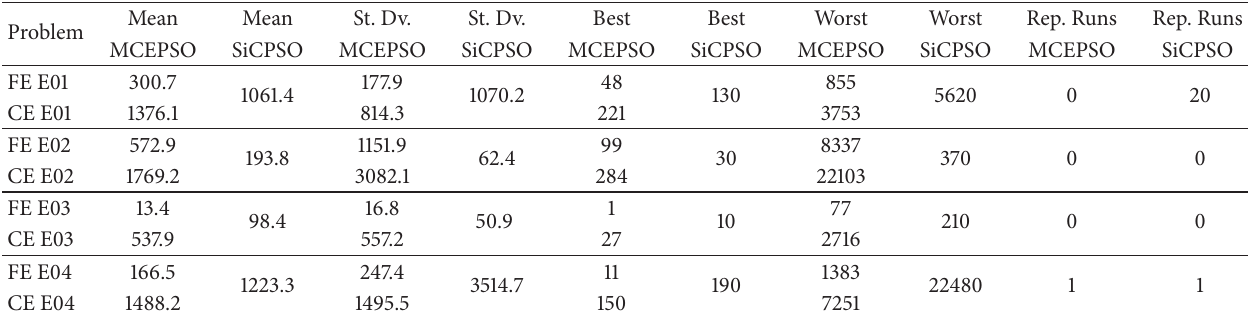
Table 9: FTT: number of evaluations obtained with 20 particles: 1500 iterations. Statistics over 50 complete runs. Mean Problem